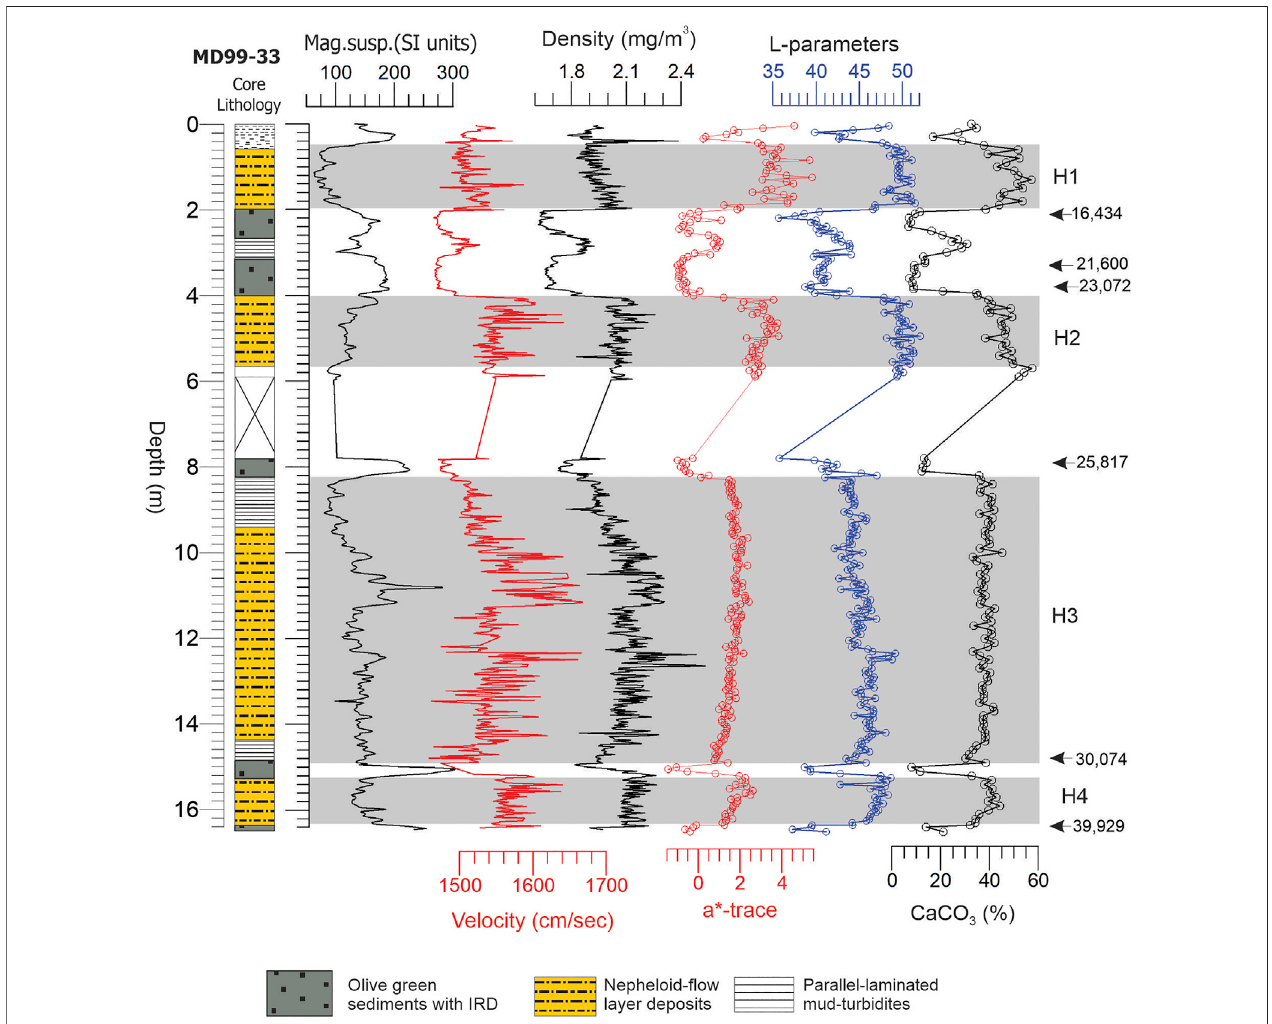
FIGURE2| Sedimentphysicalproperties,namely,magneticsusceptibility,P-wavevelocity anddensity,sedimentcolora*-trace andL*,and CaCO 3 (%)inthebulk sediments,inadditiontocorephotographsandX-radiographs,wereusedtoassignsedimentfaciesofcoreMD99-2233shownincolumn(a).Six 14 C-AMSdates,which wereconvertedtocalendaryearsusingtheCALIB8.10,areshownbytheblackhorizontalarrows.H1,H2,H3,andH4layersareidenti fi edbytheirtypicalnepheloid fl ow layer facies and detrital carbonate (re fl ected by %CaCO 3 ), constrained by the 14 C-AMS dates.